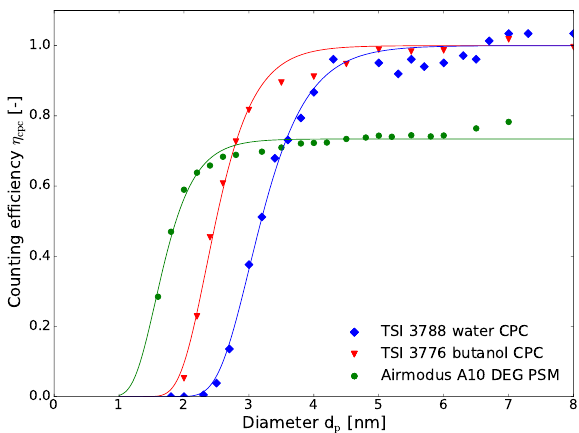
Figure 7. Characterization of the counting efficiency with silver nanoparticles for the three types of condensation particle counters used. Green represents the DEG-based Airmodus PSM A10, red the butanol-based TSI 3776 and blue the water-based TSI 3788.